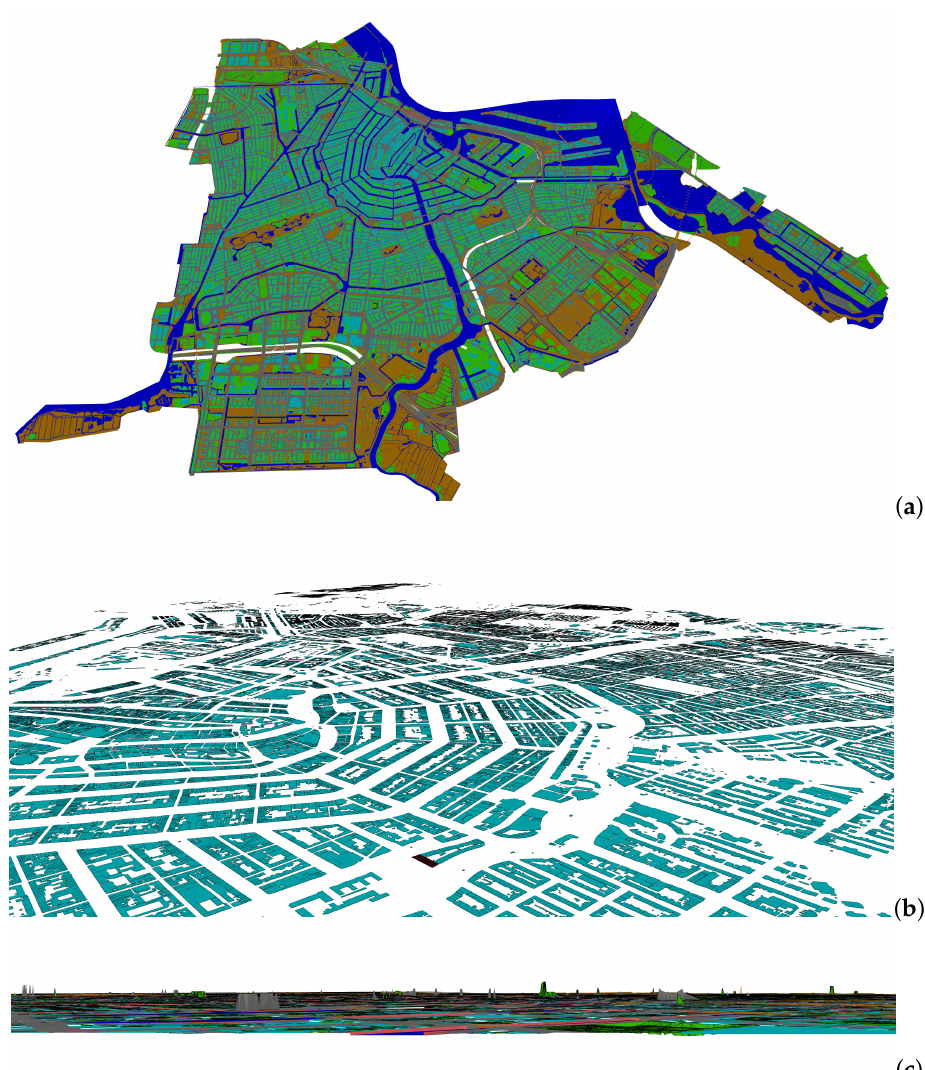
Figure 12. Result of FZK conversion of the amsterdam.gml model to IFC 2x3, visualized in RDF IfcViewer. ( a ) is the full model, ( b ) the resulting buildings and ( c ) is the side view of the model, where it is possible to appreciate the lack of heights in almost all the